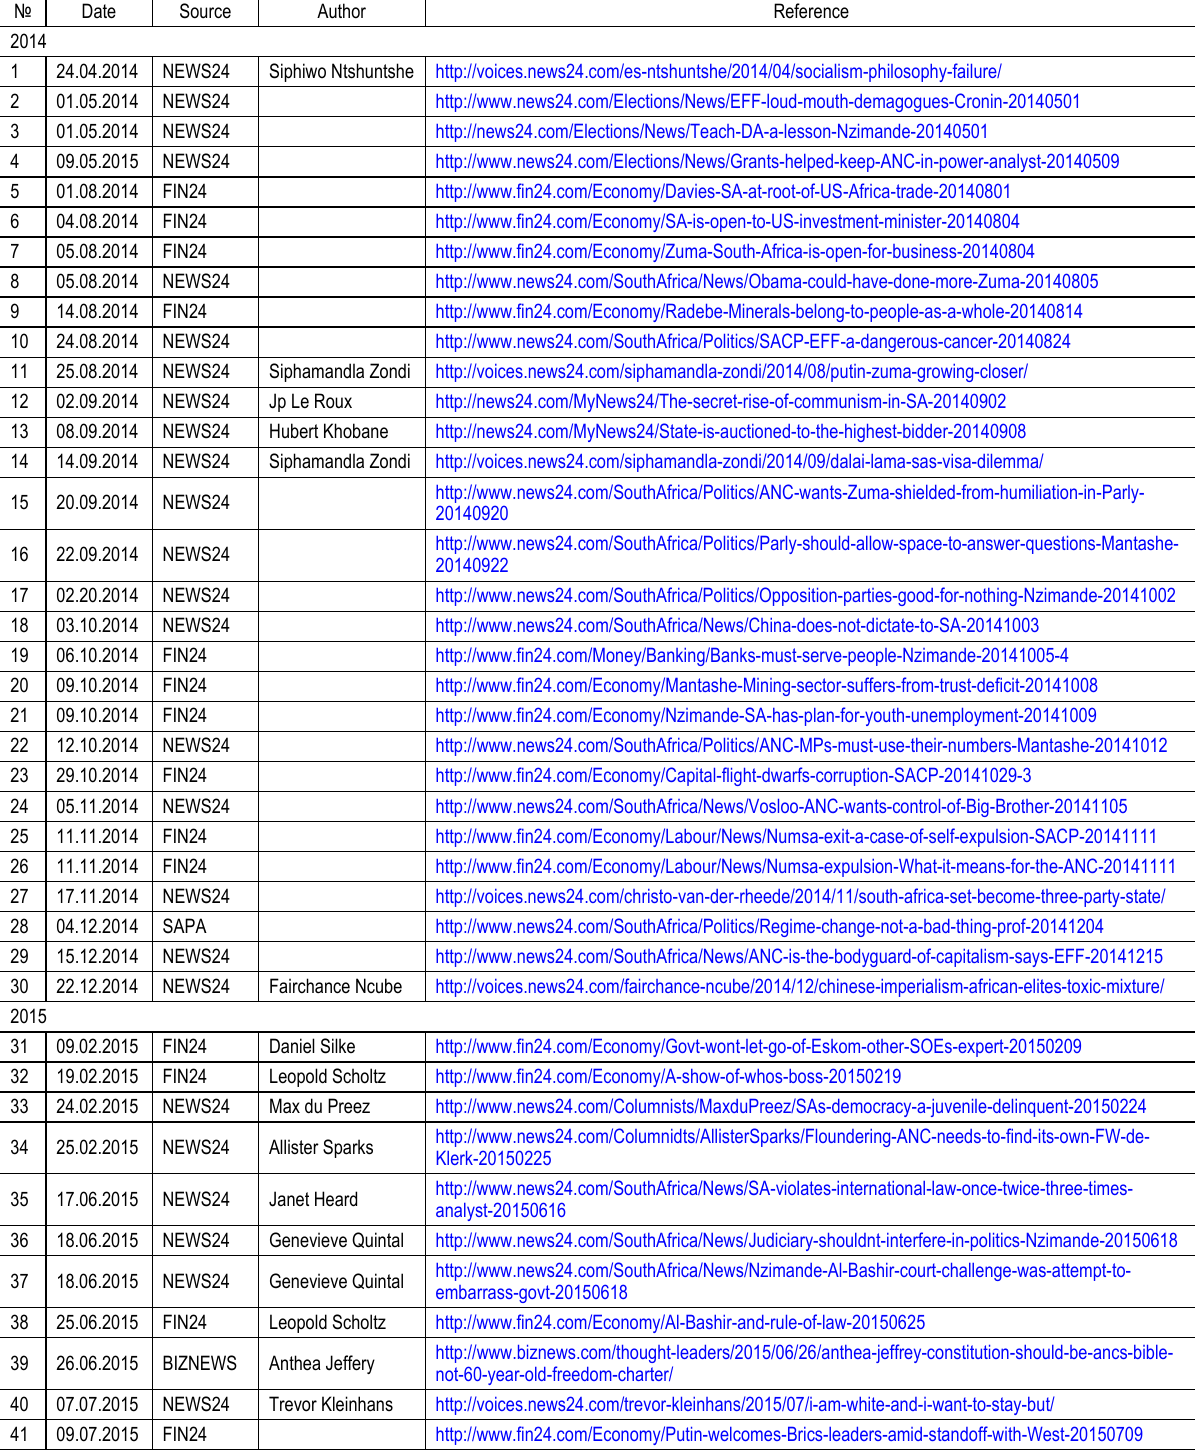
Table 2 (references). Movement towards socialism/communism of BEE (January 2014-January